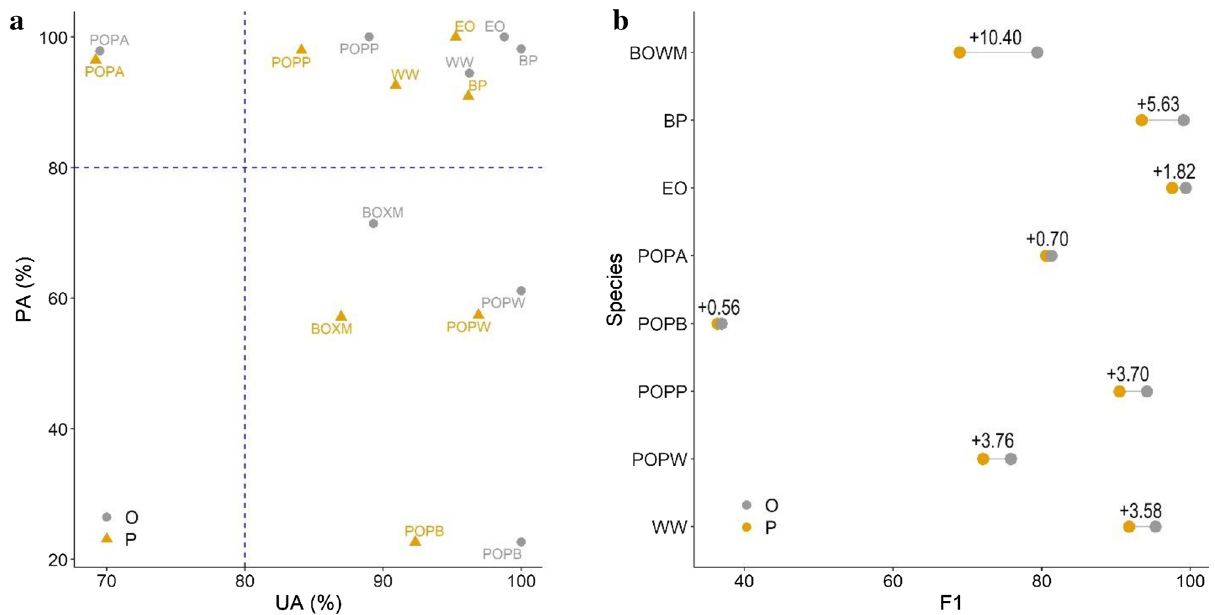
Figure 7. User’s accuracy (UA) and Producer’s accuracy (PA) of the species level classification ( a ) and F1-scores by species ( b ). 10 MCs and ML classifier and the post-classified image with L3 segments; O object-based post- classification, P pixel-based classification; WW White willow, POPA Poplar (Agathe-F), BP Black pine, POPW White poplar, BOXM Boxelder maple, POPP Pannonia poplar, POPB Black poplar, EO English oak; dashed line: 80% accuracy